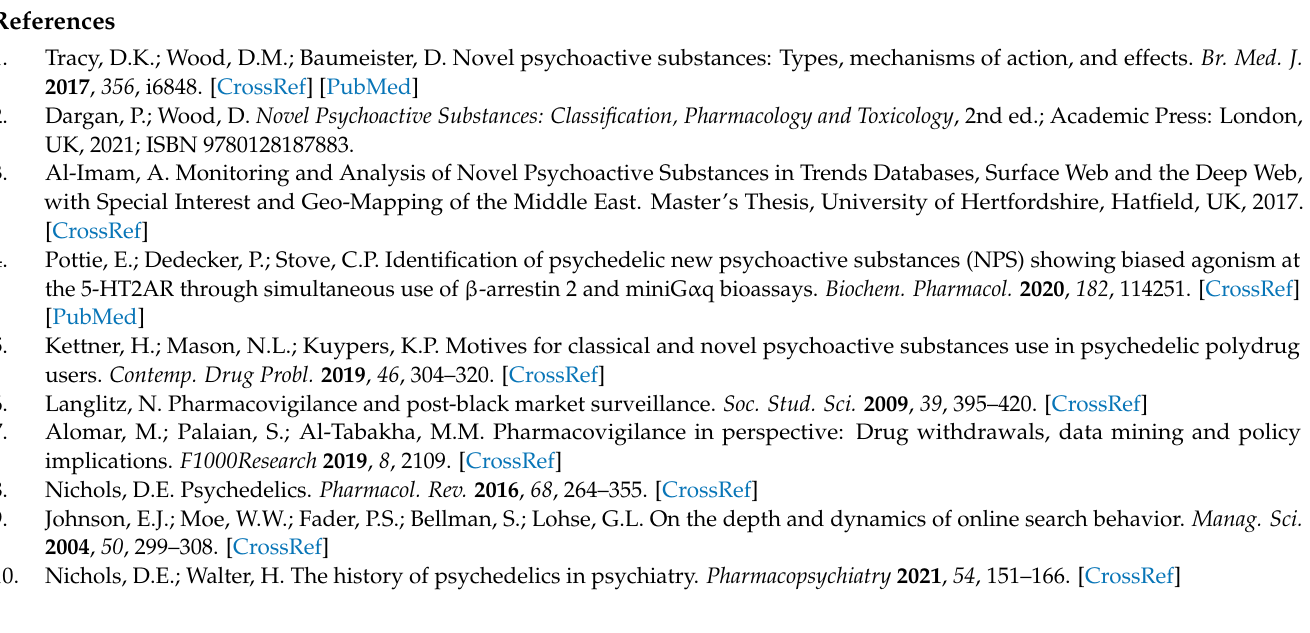
Table S2: Comparative analysis of the slopes for the time series in Poland; Table S3: Spatial Mapping Correlation with Population Demographics and Interest in the Deep Web: Holistic Period; Table S4: Spatial Mapping Correlation with Population Demographics and Interest in the Deep Web: Pre- Pandemic; Table S5: Spatial Mapping Correlation with Population Demographics and Interest in the Deep Web: Pandemic; Table S6: Binary Indexing of the Spatial Map Correlation for Pre-Pandemic versus Pandemic